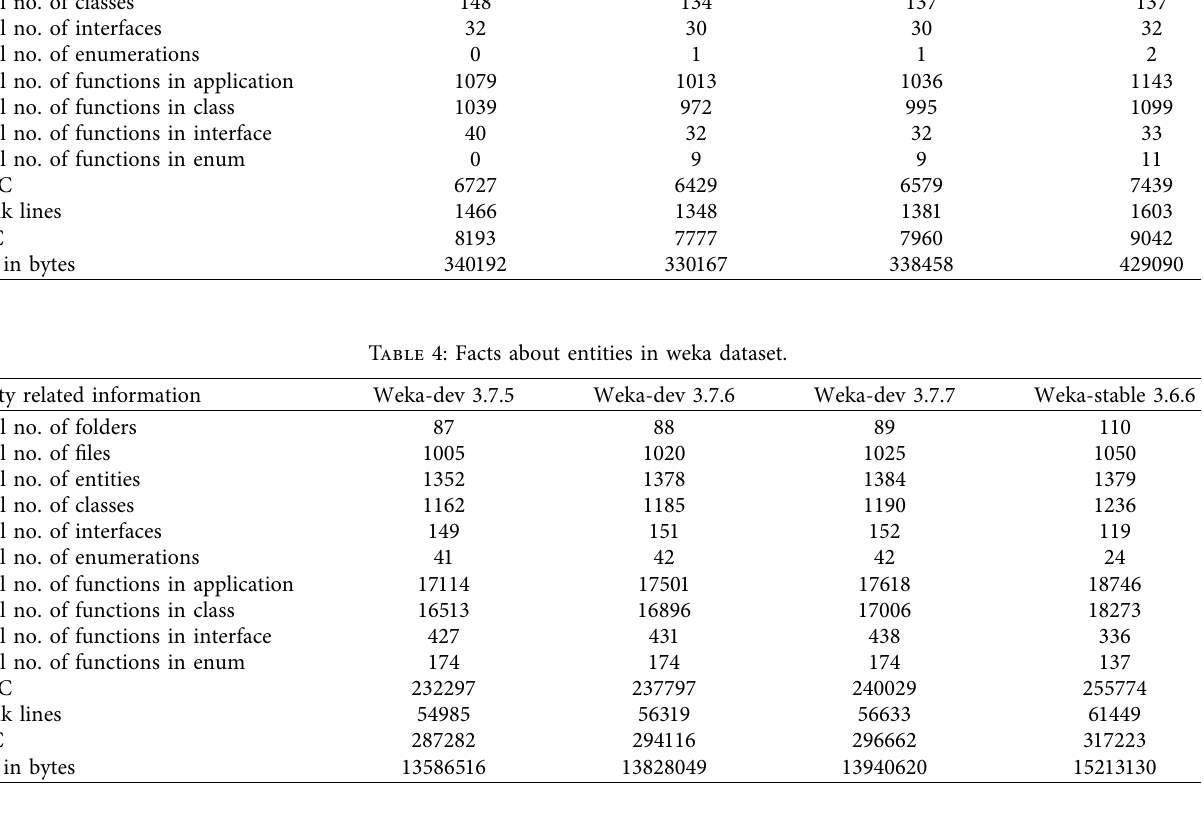
Table 5: Entities in